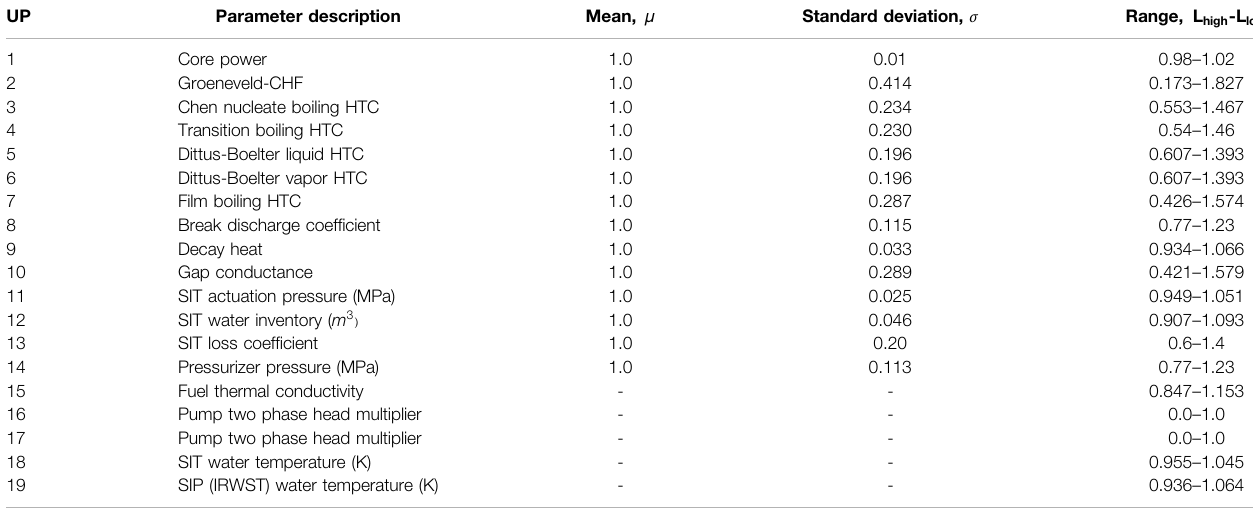
TABLE 3 | Normalized uncertain